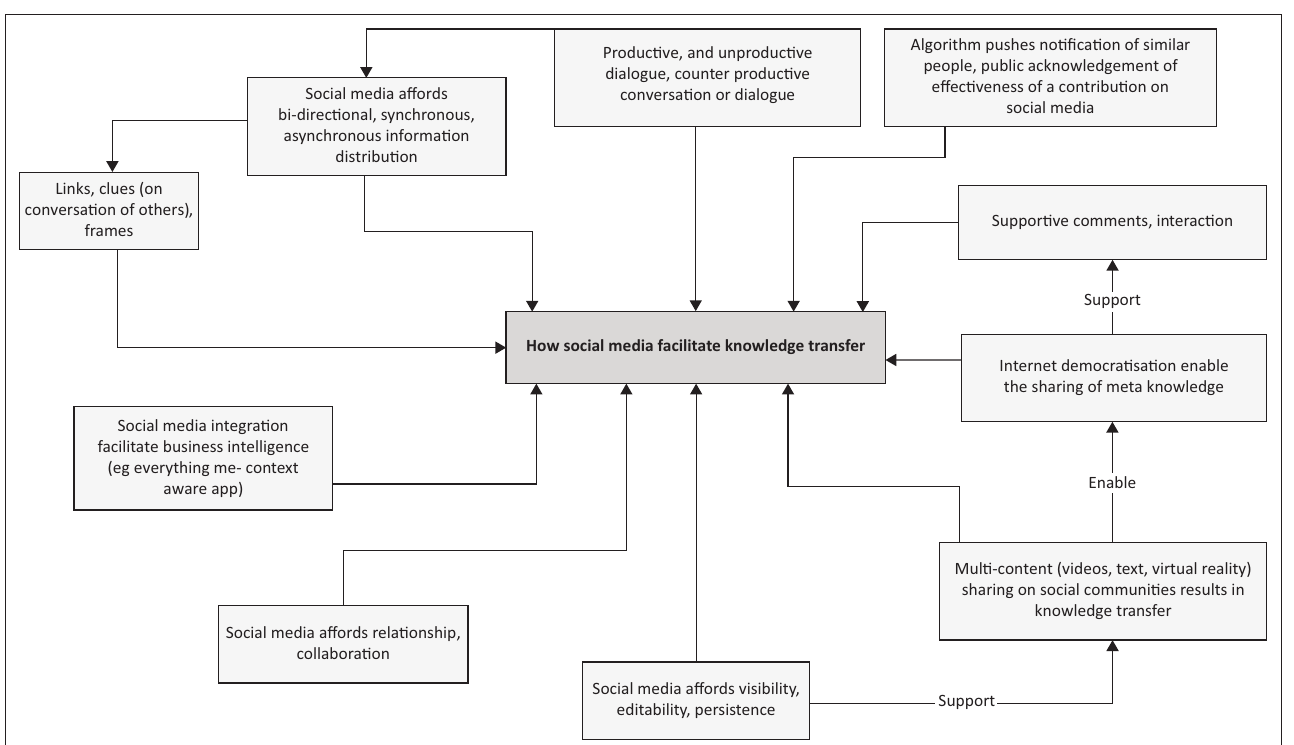
FIGURE 3: How social media affordances facilitate sense-making and knowledge